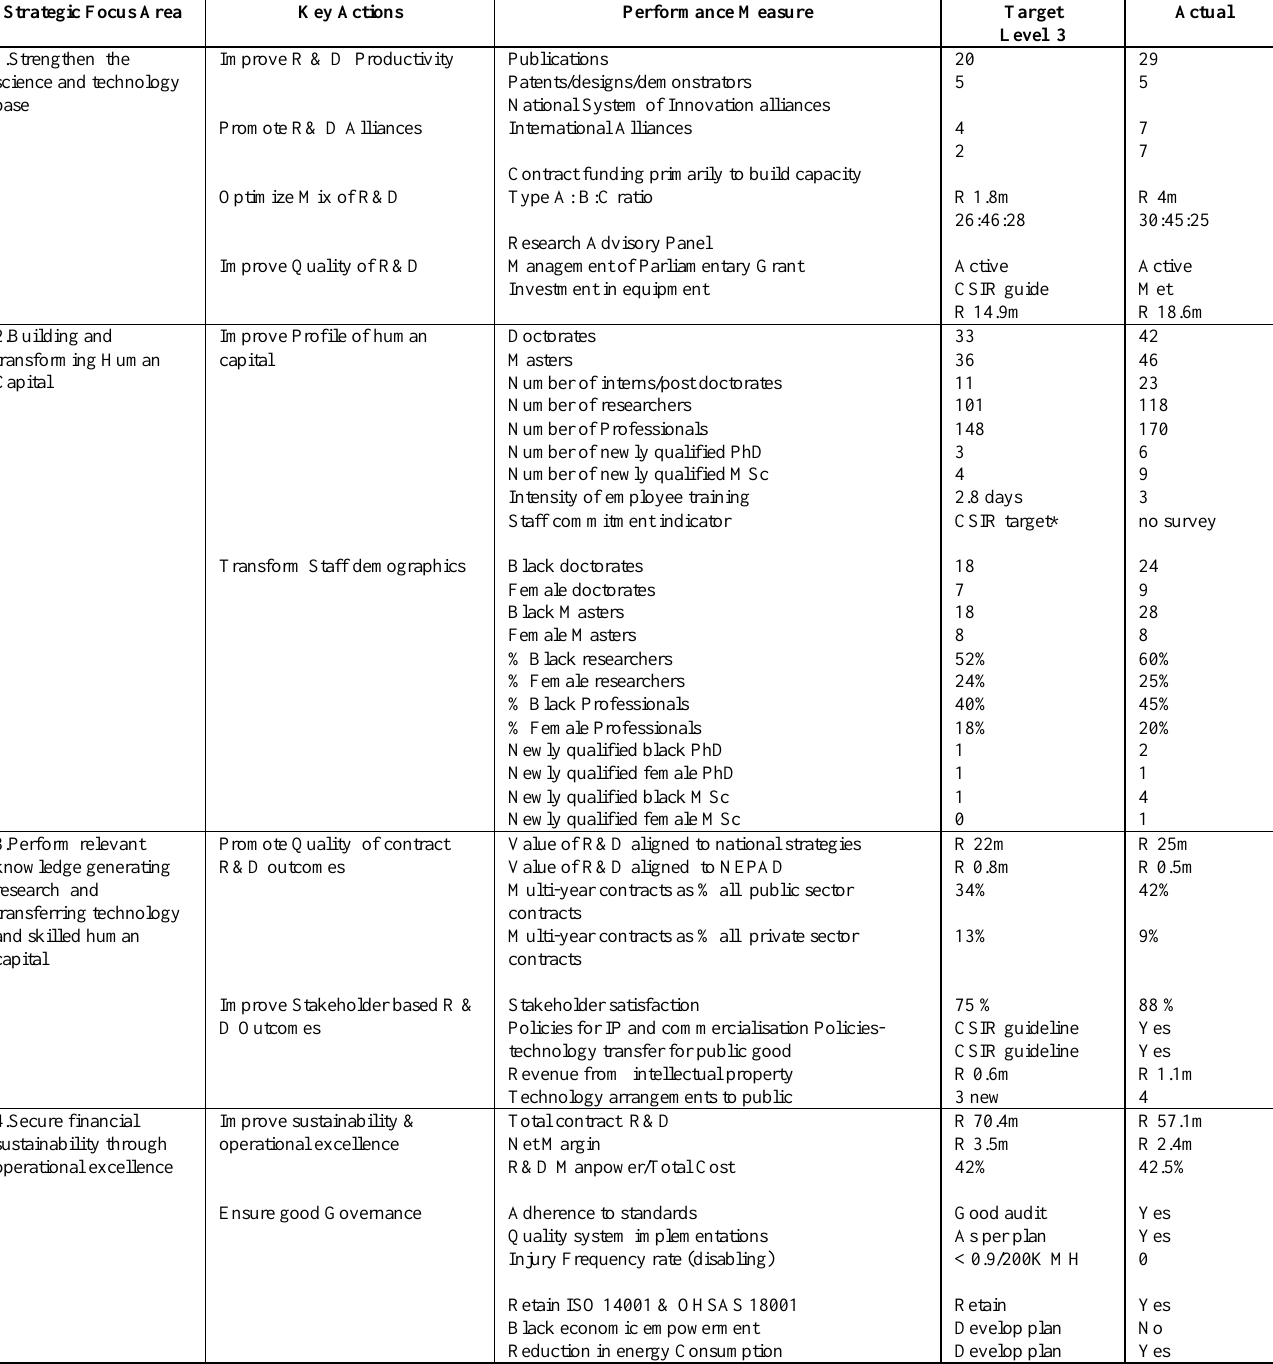
Table 2: MSM 2006/7 PMF Strategic Focus